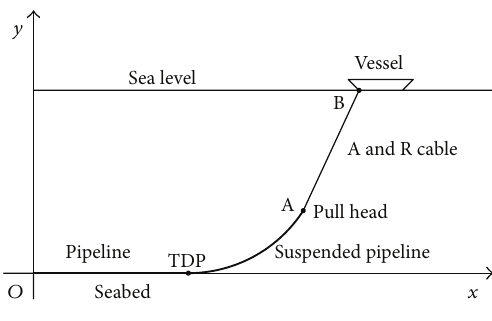
Figure 1: Pipeline abandonment and recovery